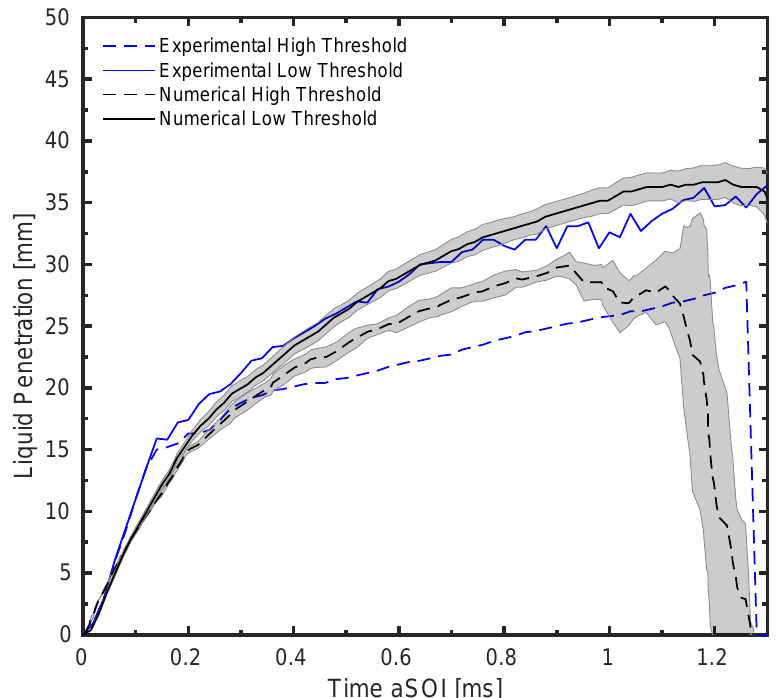
Figure 6. Numerical and experimental axial liquid phase penetration for the baseline condition (G1). High threshold corresponds to 2 × 10 − 3 mm 3 /mm 2 while low threshold corresponds to 2 × 10 − 4 mm 3 /mm 2 liquid volume